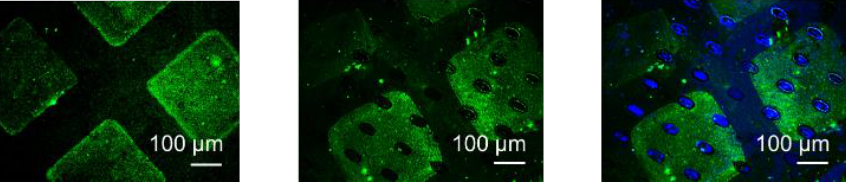
Figure 2. ( a ) Schematic illustration of the surface modification platform based on the erasable coating to provide spatially confined accessibilities of (i) specific conjugation to alter the surface chemistry, (ii) an erasable mechanism to remove the existing chemistry, and (iii) reactivation of the surface property for a second divergent chemistry via a disulfide interchange route. ( b ) A demonstration of using the erasable coating to confine the conjugations of multiple fluorescent molecules on the same surface. Fluorescein (FITC)-Arg-Arg-Cys-Cys (RRCC) (green signals) was conjugated to the surface at selected areas in a 300 µ m × 300 µ m square pattern (fluorescence micrograph on the left), and subsequent removal of the conjugated FITC-RRCC occurred with a second independent oval pattern (major axis = 50 µ m, minor axis = 20 µ m) in the middle (erased green signals). Finally, reactivation occurred to install a divergent molecule system of cysteamine / Alexa Fluor 350 NHS ester (blue channel) in the oval pattern areas, as shown to the